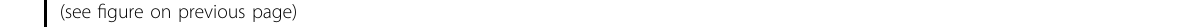
Fig. 3 Antibody design and validation based on germline and CDR3 analysis. a Work fl ow of antibody identi fi cation and functional analysis. Potential antibody sequences were predicted according to screening strategies described in “ Materials and methods ” . The antibodies were then constructed and expressed for further functional analysis. b Binding curves of fi ve representative mAbs to S-RBD. S309 is a positive control while hIgFC is a negative control. c Binding curves of fi ve representative mAbs to S-ECD. 4A8 is a positive control that was reported to bind the S-ECD of SARS-CoV-2. d Diagram showing the binding of mAbs (EC 50 value) to S-ECD determined by ELISA. EC 50 values greater than 100 μ g/mL are indicated as ">". e Pseudotyped virus neutralization assay to test the neutralization potency with gradient diluted P3V6-1. Infected cells were identi fi ed as GFP- positive cells. Images were obtained by using fl uorescence microscopy. Scale bars, 40